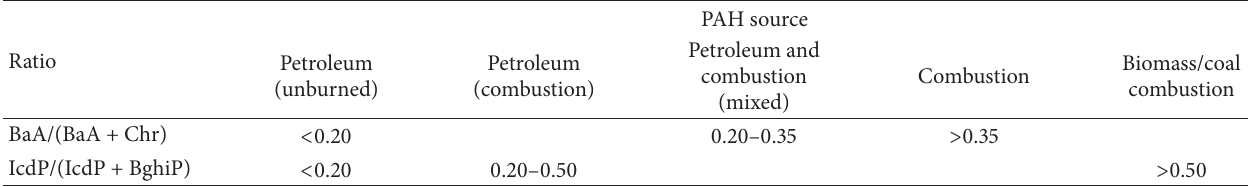
Table 2: PAH isomer ratios commonly used in the identification of PAH sources.